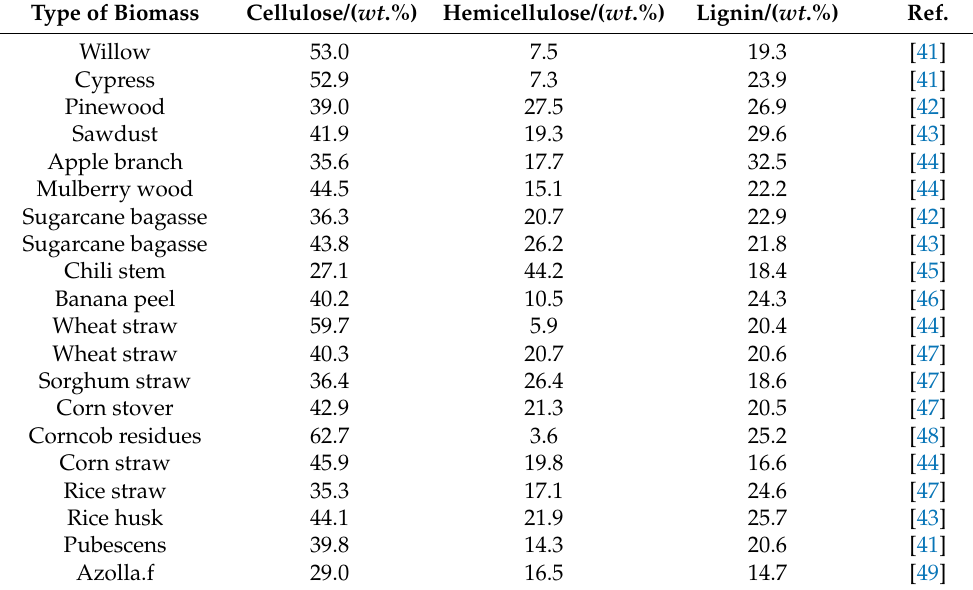
Table 1. The different contents of the three main components for common biomass. Type of Biomass